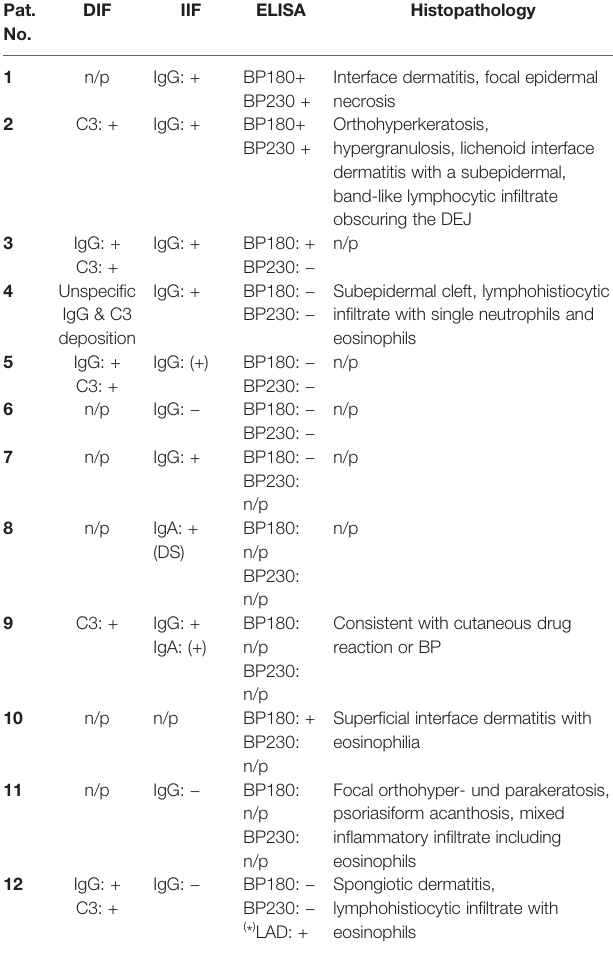
TABLE 2 | Summary of immuno- and